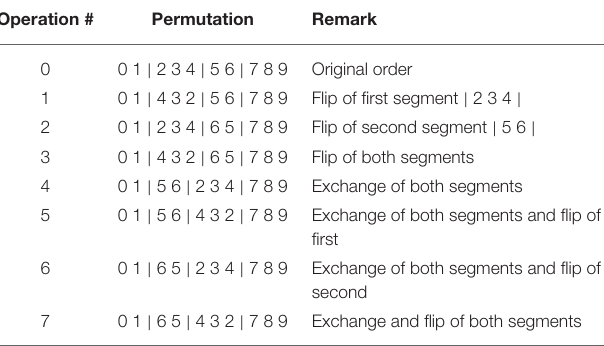
TABLE 1 | List of possible 3-opt operations based on a 10-points example. Operation # Permutation